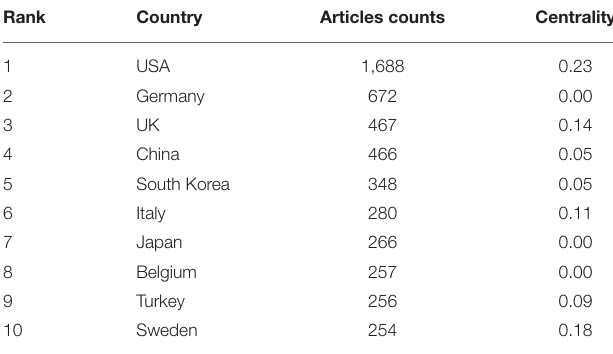
TABLE 1 | Ranking of top 10 most published countries in tinnitus research from 2001 to 2020. Rank Country